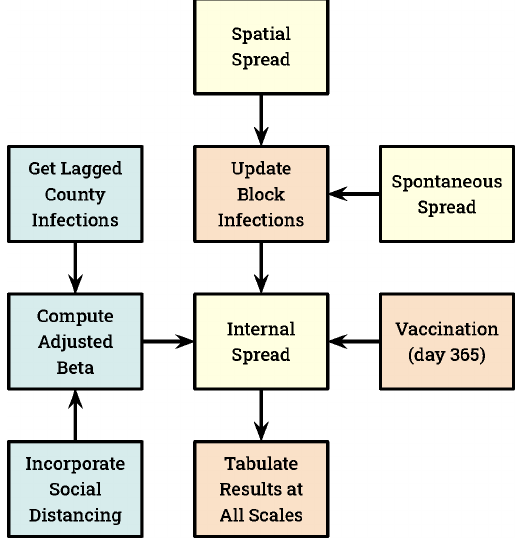
Figure 2. A schematic diagram of the spatial simulation model illustrating key mechanisms that run every day (except vaccination). All SIRD calculations are made at the block scale, and these values are aggregated to the larger spatial structures each day. Our three disease spread mechanisms are indicated in yellow.